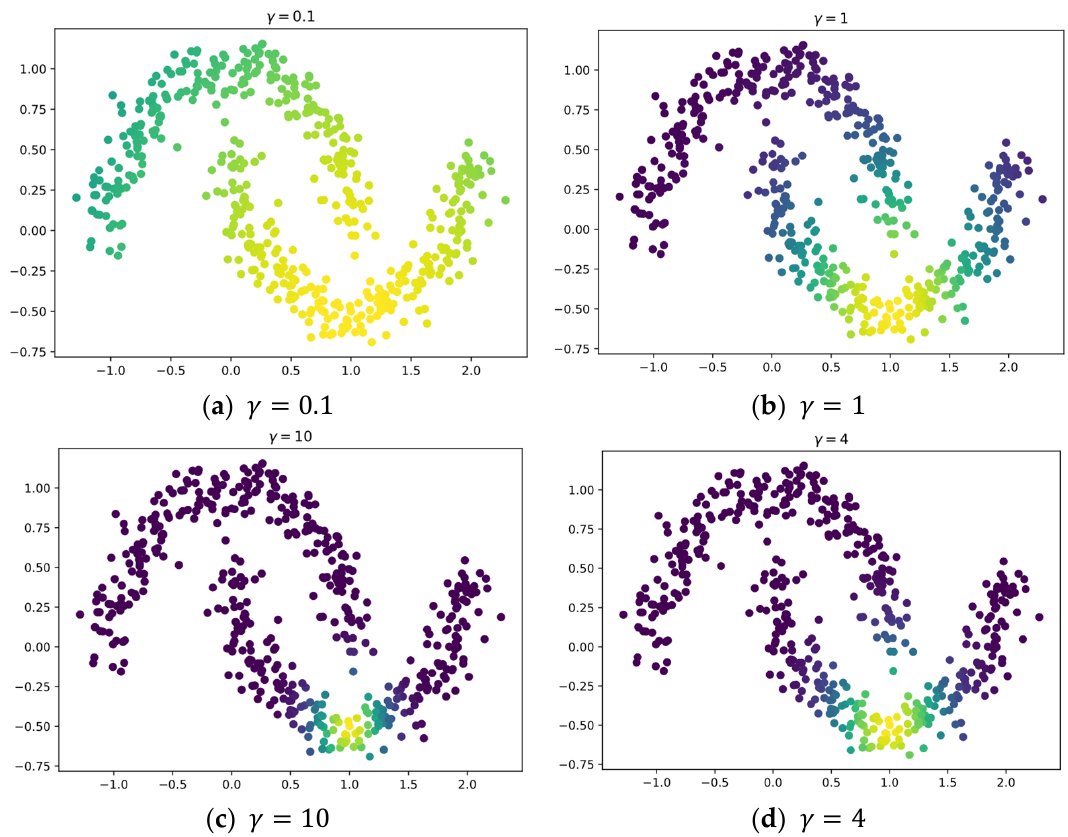
Figure 1. Illustration of the importance of the width parameter γ of the RBF kernel from semi- supervised learning; ( a ) shows a poor selection of the width parameter γ = 0.1 that misleads the model into perceiving that all data belong to the same class; ( b ) shows a better selection of the width parameter γ = 1 as most of the mass is concentrated on data in the same class but touches many of the data in the opposite class; ( c ) also shows a poor selection of the width parameter γ = 10 as it only indicates that only the most similar data from the center belong to the same class; ( d ) shows the best width parameter γ = 4 among the other four as it specifies a wide enough region of data that belong to the same class.